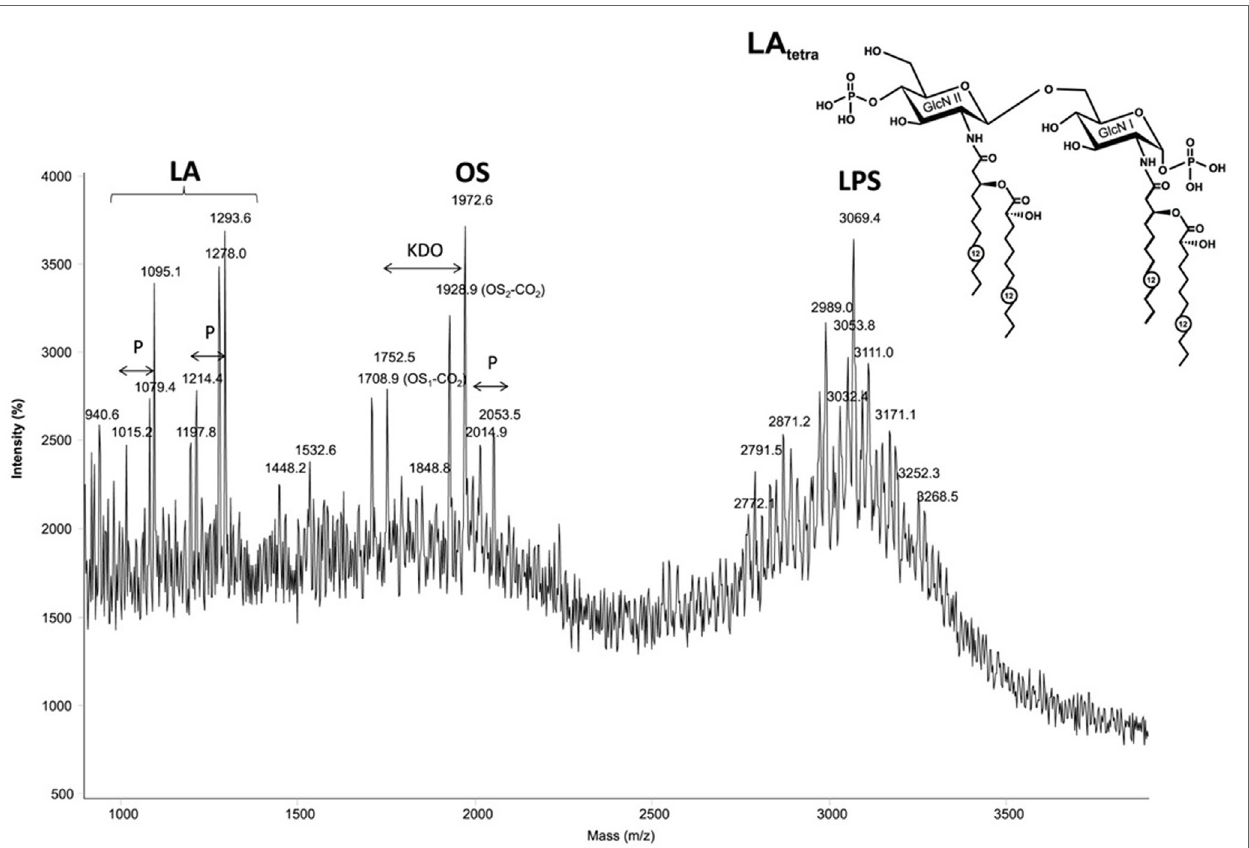
FigUre 3 | The MalDi-TOF mass spectrum of the Pseudomonas aeruginosa 2192 in the linear negative mode contained three distinct clusters of ions, corresponding to lipid a fragments, core fragments and intact lPs, respectively (listed in the order of increasing molecular mass) . Structure of the tetraacyl lipid A in LPS from P. aeruginosa. GlcN, glucosamine. Numbers indicate the number of carbon atoms in the acyl